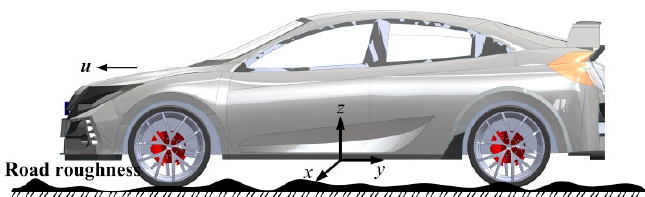
Figure 5. Schematic diagram of the vehicle affected by rough road